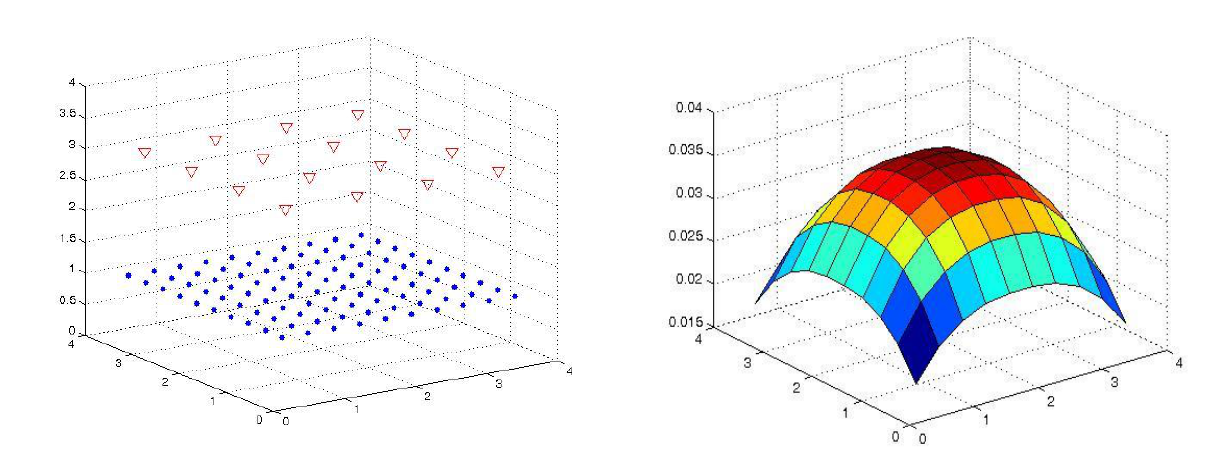
Figure 2. Scenario with 16 LED lamps and 100 receivers. Figure 3. Distribution of the received optical power at 1